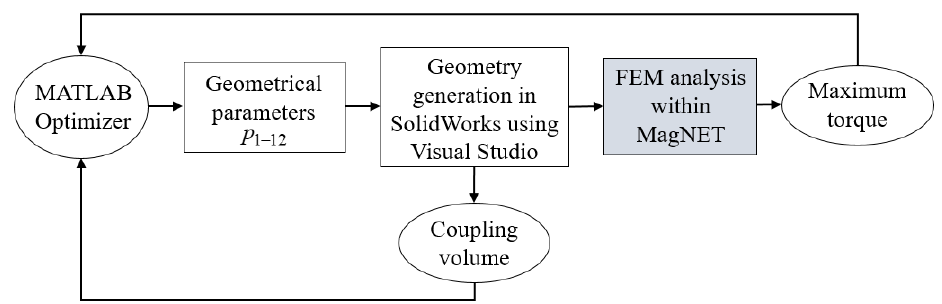
Figure 5. Optimization flowchart.